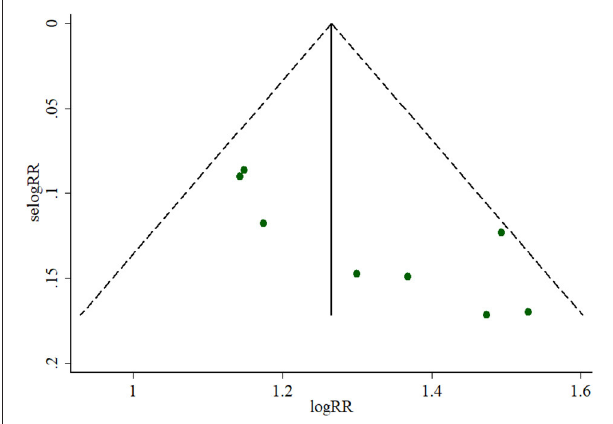
FIGURE 5 | Funnel plot of outcome measure ECG.